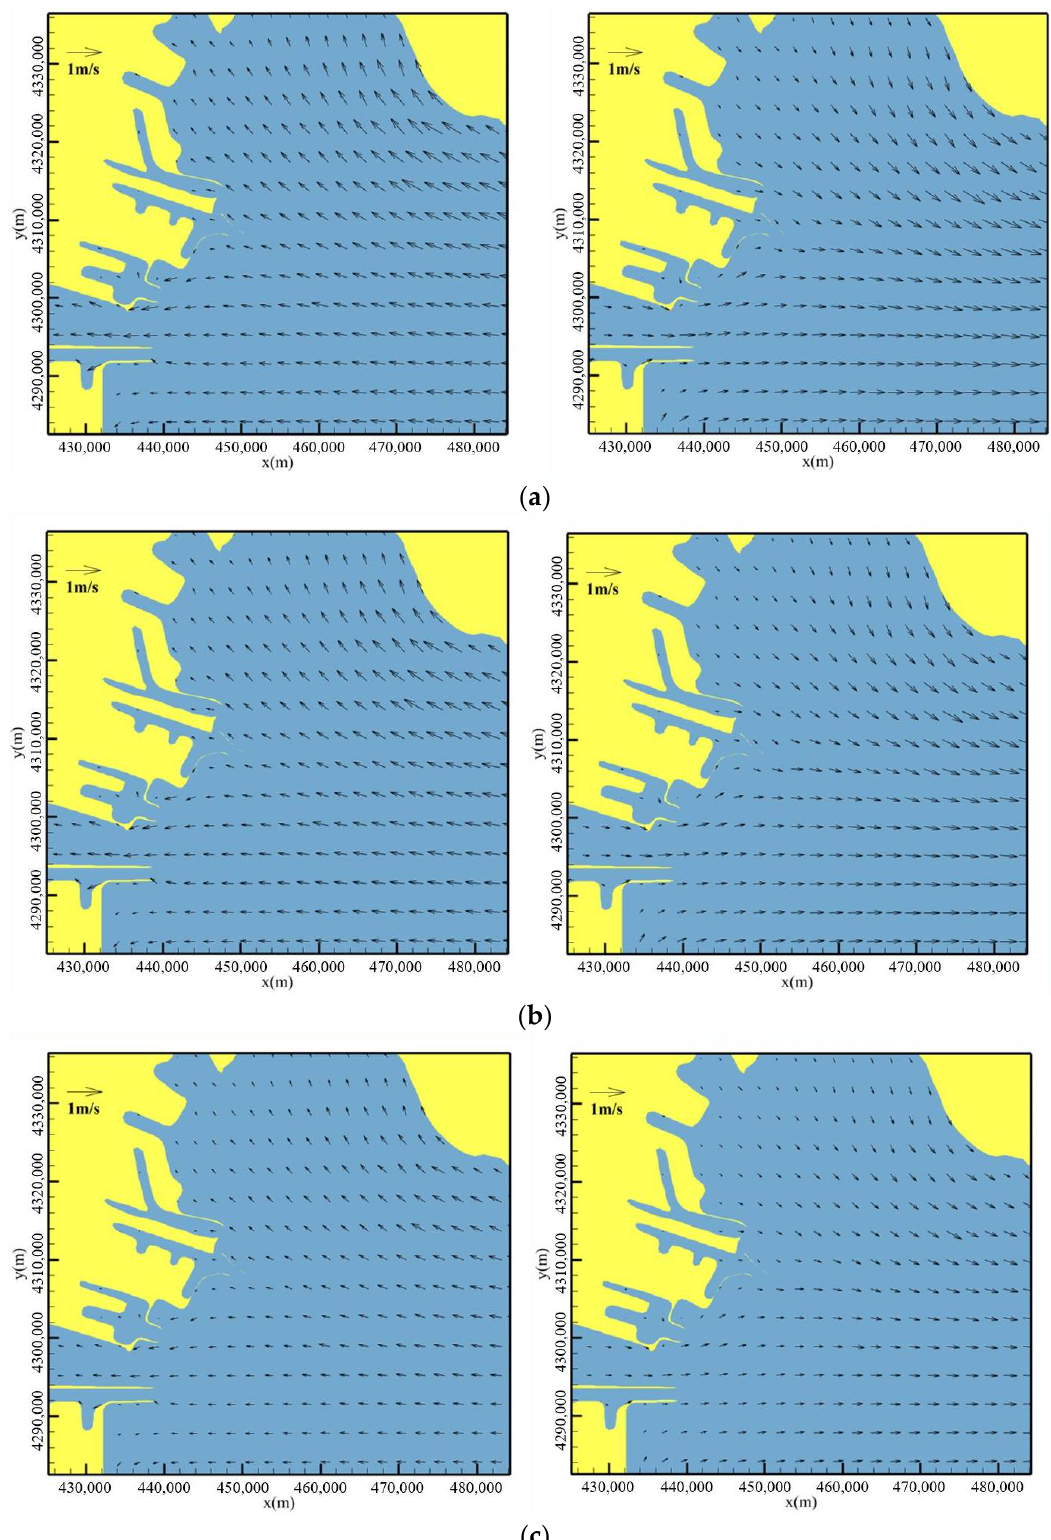
Figure 8. Flow field at different levels at the flood tide (left column) and the ebb tide (right column). ( a ) surface ( σ = 0 ); ( b ) middle ( σ = −0.5 ); ( c ) bottom ( σ = −1.0 ).